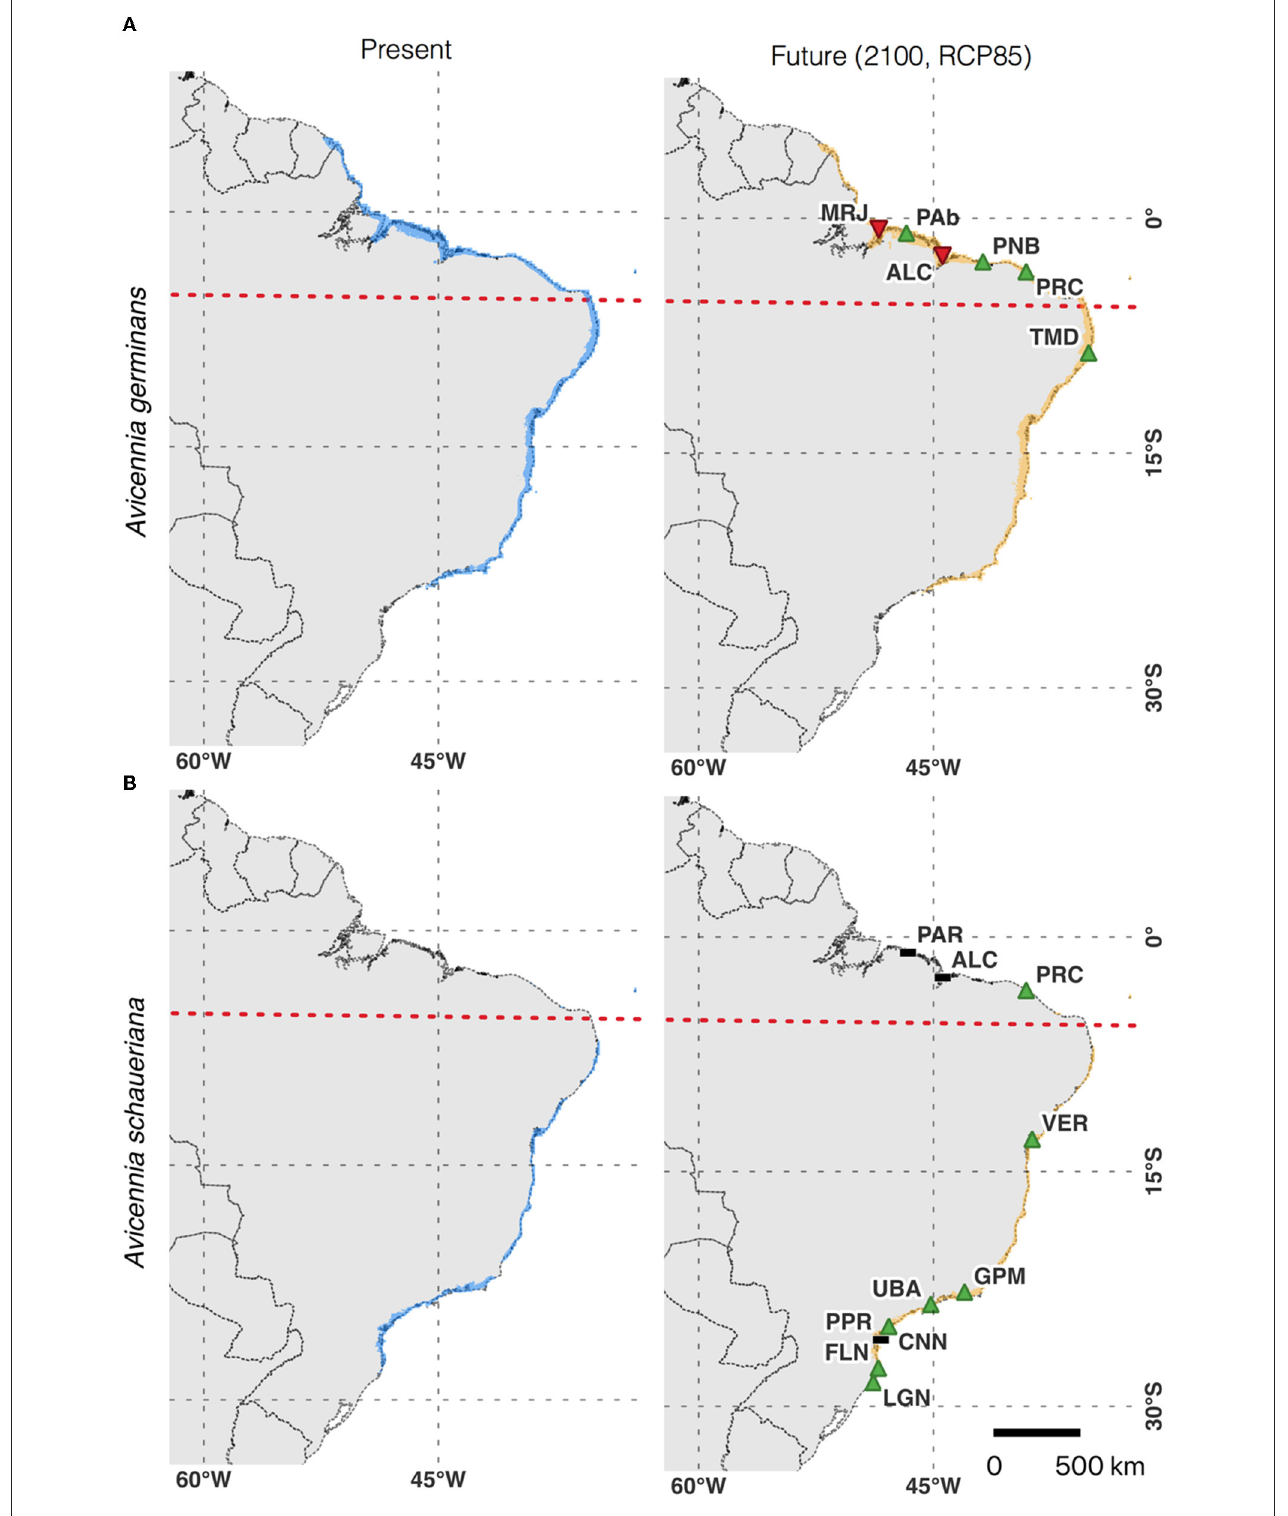
FIGURE 5 | (A) Climate-only ensemble distribution model of Avicennia germinans for current and future climate scenarios and individual population trends. (B) Climate-only ensemble distribution model of Avicennia schaueriana for current and future climate scenarios and individual population trends. The dashed red line represents the north–south population division found in the northeast extremity of South America (NEESA).